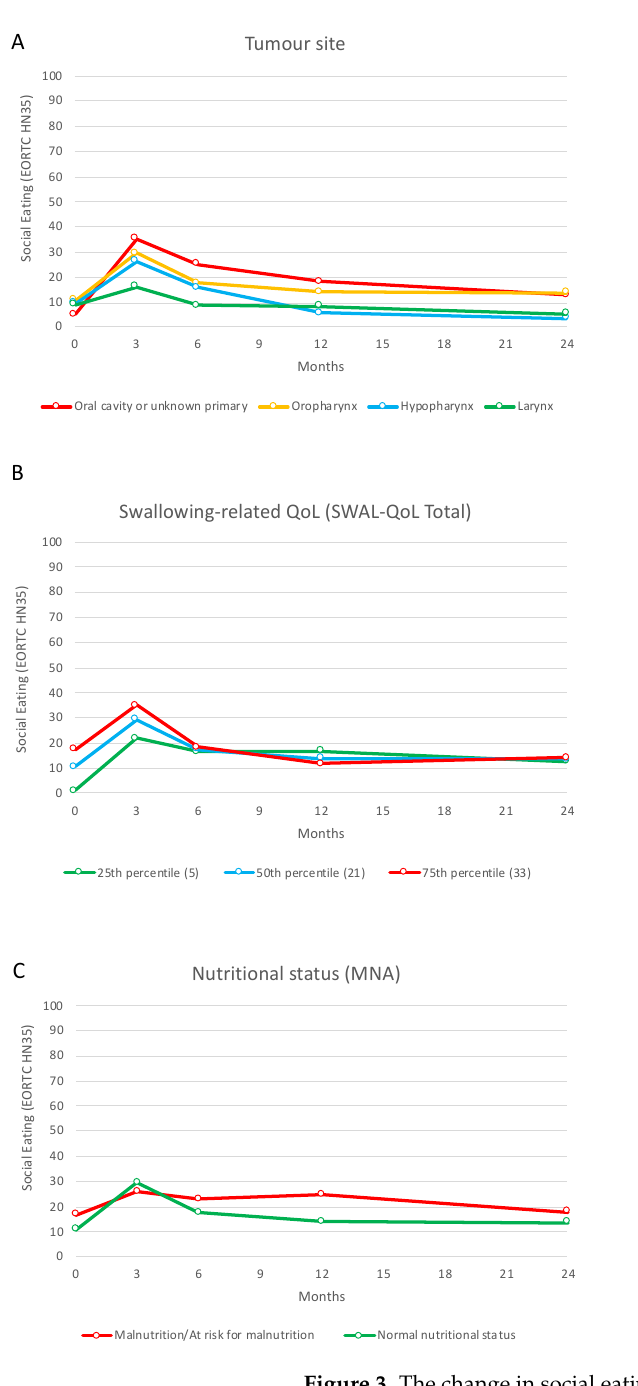
Figure 3. The change in social eating problems (EORTC QLQ HN35) from baseline to 24 months after treatment in relation to tumor site ( A ), swallowing-related Quality of life ( B ), nutritional status ( C ), depressive symptoms ( D ), swallowing symptoms ( E ), and age ( F ) at baseline.